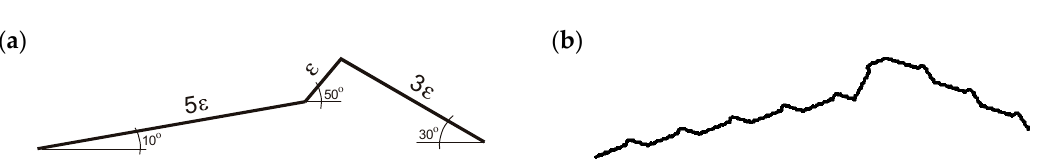
Figure 12. Generator and the fractal obtained on its basis ( N —number of parts making up the initial figure of the fractal, s —scale factor). ( a ) generator; ( b ) fractal obtained on its basis.